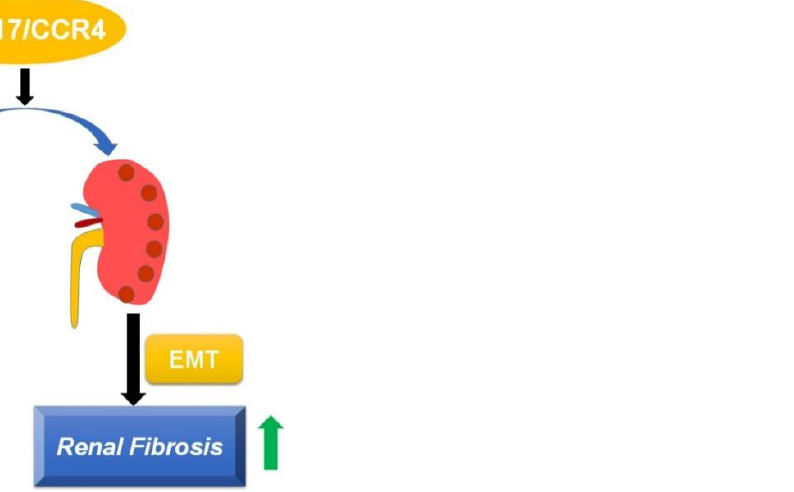
Figure 6. Schematic of CCL17-mediated EMT and fibrotic yields, followed by promoting the devel- opment and progression of renal fibrosis.